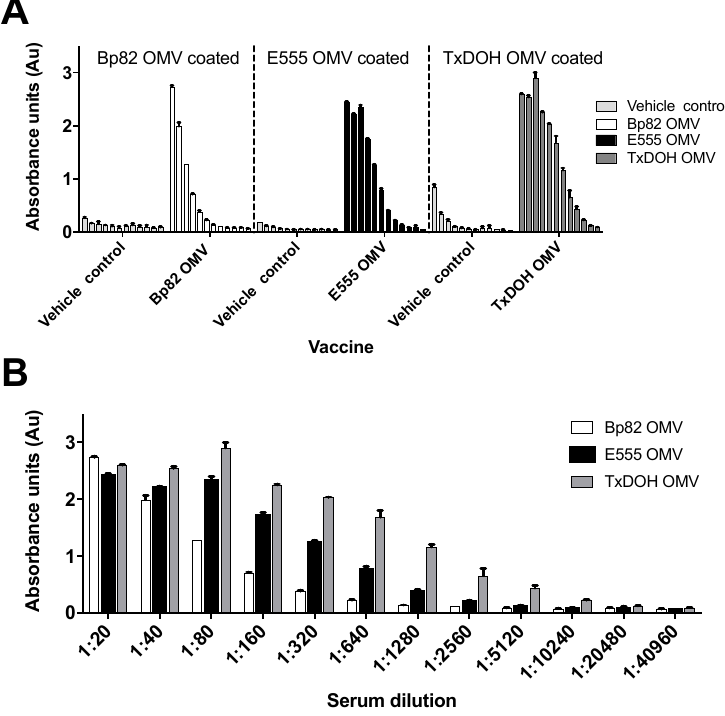
Figure 3. Stronger OMV specific antibodies are produced after vaccination with B. thailandensis -derived OMVs. ( A ) Average reactivity of serially diluted serum from OMV-vaccinated mice to the immunogenic material is specific compared to serum from vehicle control-vaccinated mice. ( B ) Endpoint serum dilution compared between OMV vaccinated groups measured by ELISA and represented as absorbance units at 450 nm.